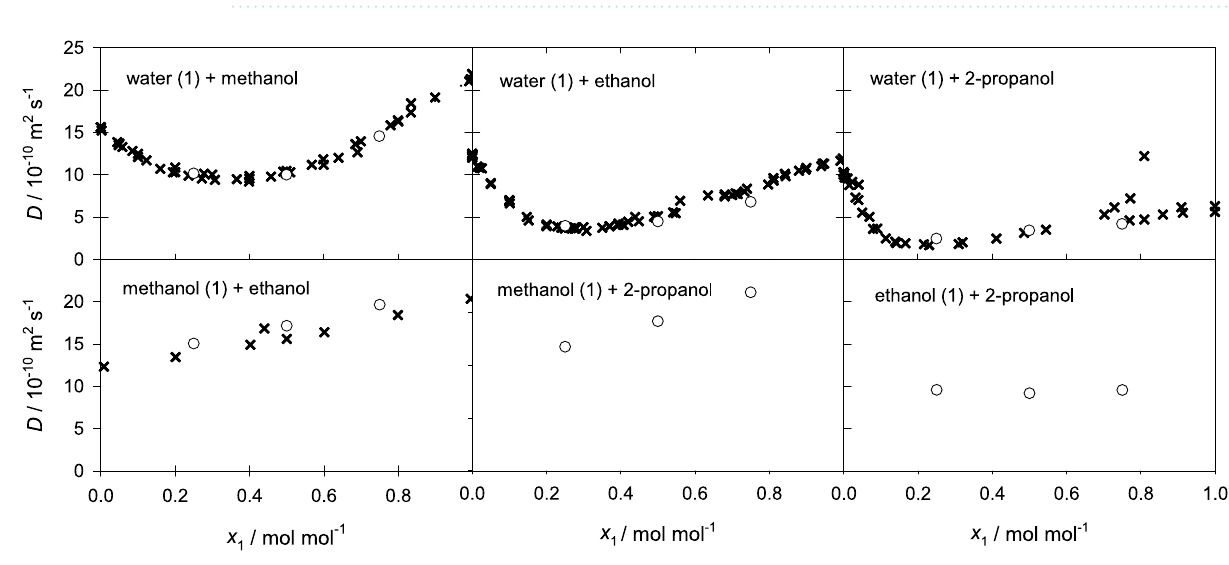
Figure 6. Elements of the Fick diffusion coefficient matrix in the molar (black circles), volume (blue squares) and mass reference frame (red triangles) of the ternary subsystem water (1) + ethanol (2) + 2-propanol (3) with x 3 = 0.25 molmol − 1 at 298.15 K and 0.1 MPa. The green crosses represent the expected values in the binary limit x 1 → 0 for the molar reference frame.